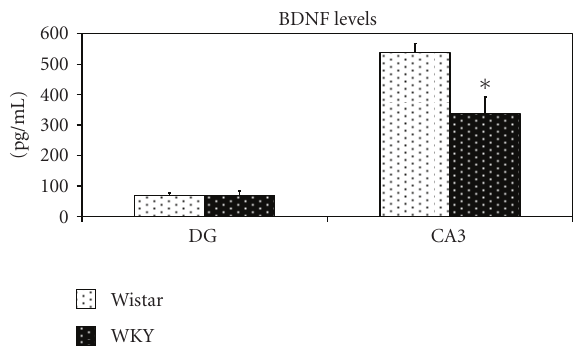
Figure 2: Mean basal levels of BDNF in the DG and CA3 ( ± SEM) of 34-35 day old Wistar versus WKY rats ( N = 5-6 each group). ∗ P < .